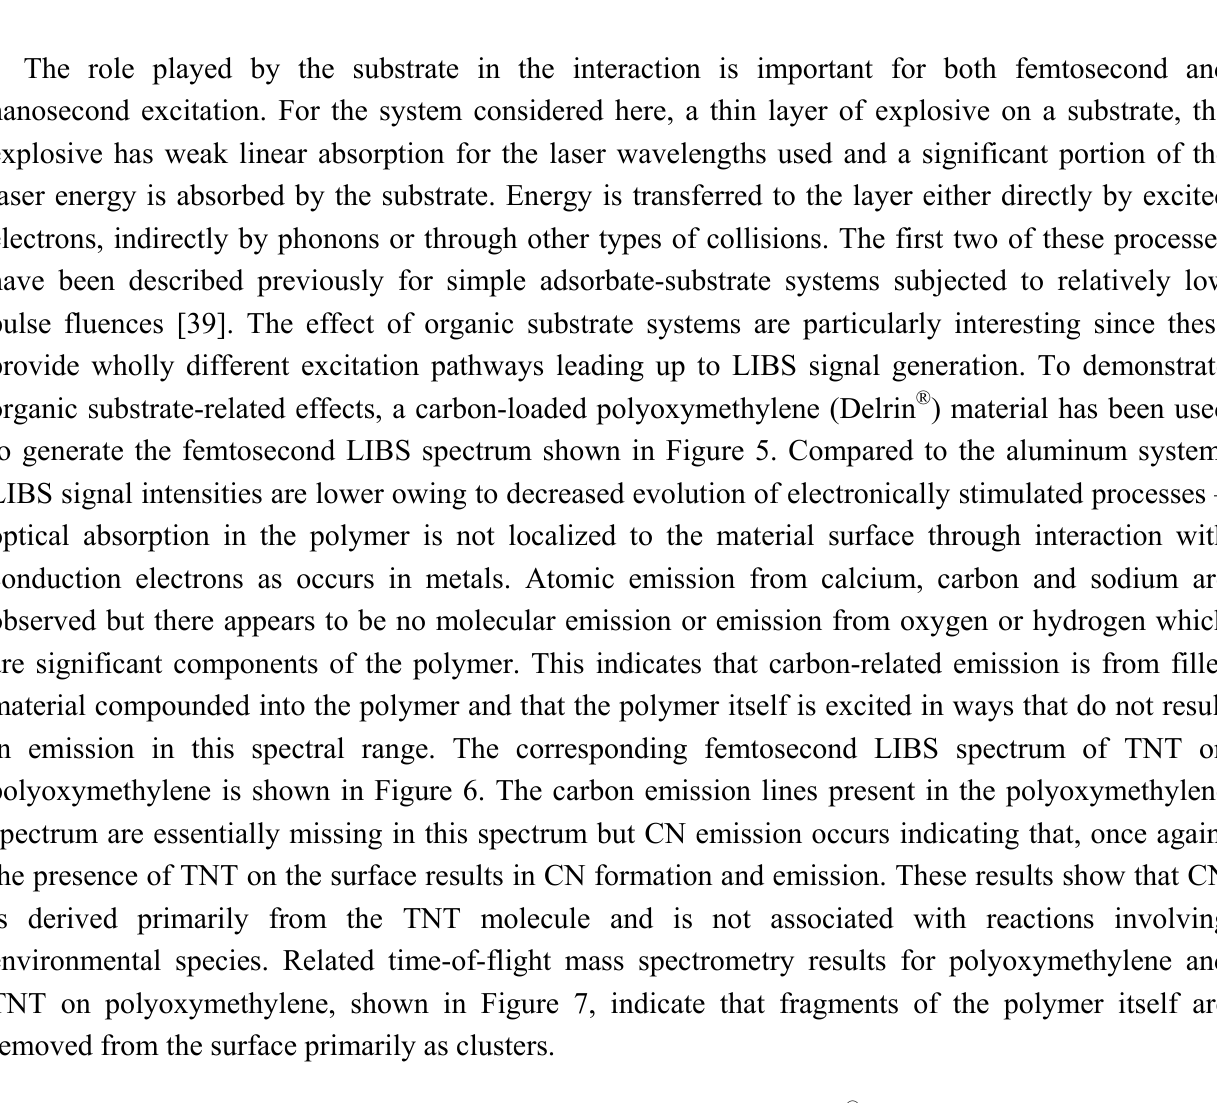
Figure 5. Femtosecond LIBS spectrum of polyoxymethylene (Delrin ® ) loaded with a carbon